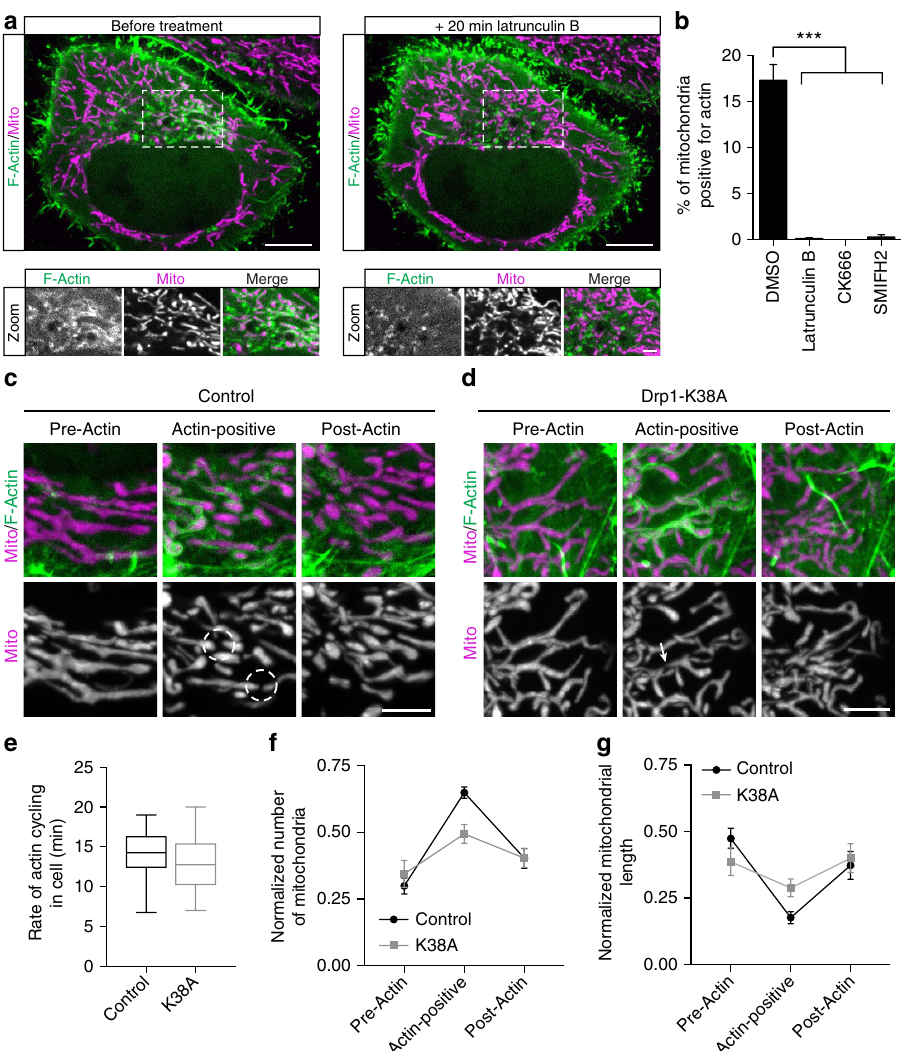
Figure 6 | Actin cycling is dependent on actin polymerization by Arp2/3 and formins but not Drp1 activity. ( a ) Confocal images of F-actin (LifeAct-GFP) localized to a mitochondrial subpopulation (Mito-DsRed2) during constitutive cycling (left) in a HeLa cell. Actin recruitment to mitochondria was abolished on 20min treatment with the actin depolymerizing drug Latrunculin B (2 m M) (right). ( b ) F-actin assembly on mitochondria was blocked in cells treated with 2 m M Latrunculin B (30min), 84 m M CK-666 (1h), or 25 m M SMIFH2 (1h). ( c , d ) Maximum intensity projections, indicating F-actin (LifeAct-GFP) assembly onto and disassembly off of mitochondria (Mito-DsRed2) in HeLa cells transfected with either ( c ) an empty vector or ( d ) Drp1-K38A. For three-dimensional renderings of mitochondria undergoing fragmentation in control cells, see Supplementary Fig. 8. ( e ) Mean duration of actin cycling through the entire mitochondrial network in control and Drp1-K38A-expressing cells. ( f , g ) Normalized number and length of mitochondria before, during and after actin ssembly in either control or Drp1-K38A-expressing cells. Values represent mean ± s.e.m. *** P o 0.001. Scale bars, 10 m m ( a full size); 5 m m ( c , d ); 2.5 m m ( a , zoom). Sample size: ( b , dimethyl sulfoxide, DMSO) 9 cells, ( b , Latrunculin) 91 cells, ( b , CK-666) 101 cells, ( b , SMIFH2) 24